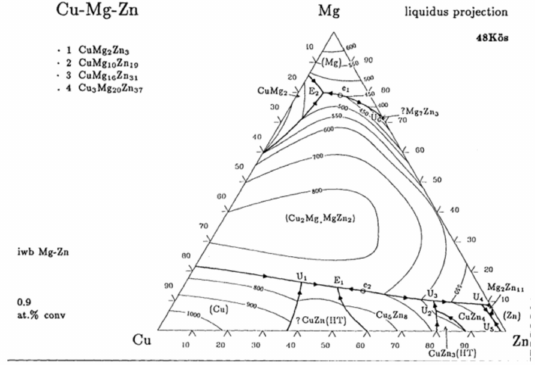
Figure 4. Phase diagram of Cu–Mg–Zn alloy [20].